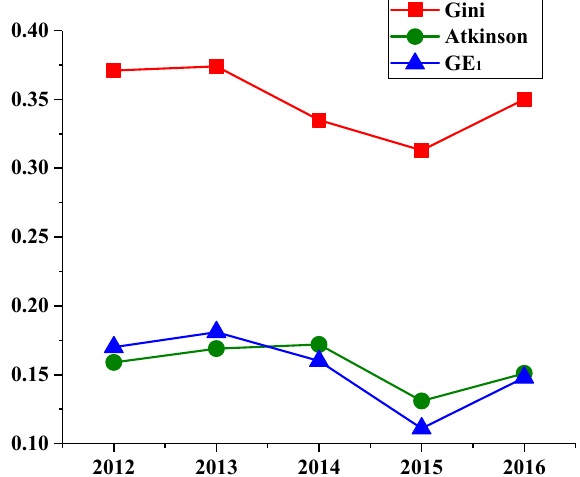
Figure 6. Inequality measurement of ecological civilization construction in Jiangsu Province.